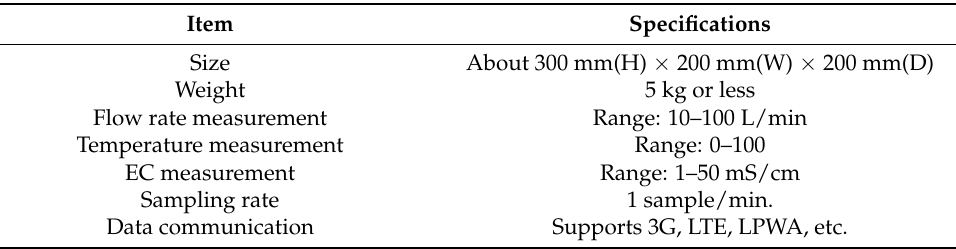
Figure 2. Photograph of the hot spring monitoring device. Table 1. Main specifications of the hot spring monitoring